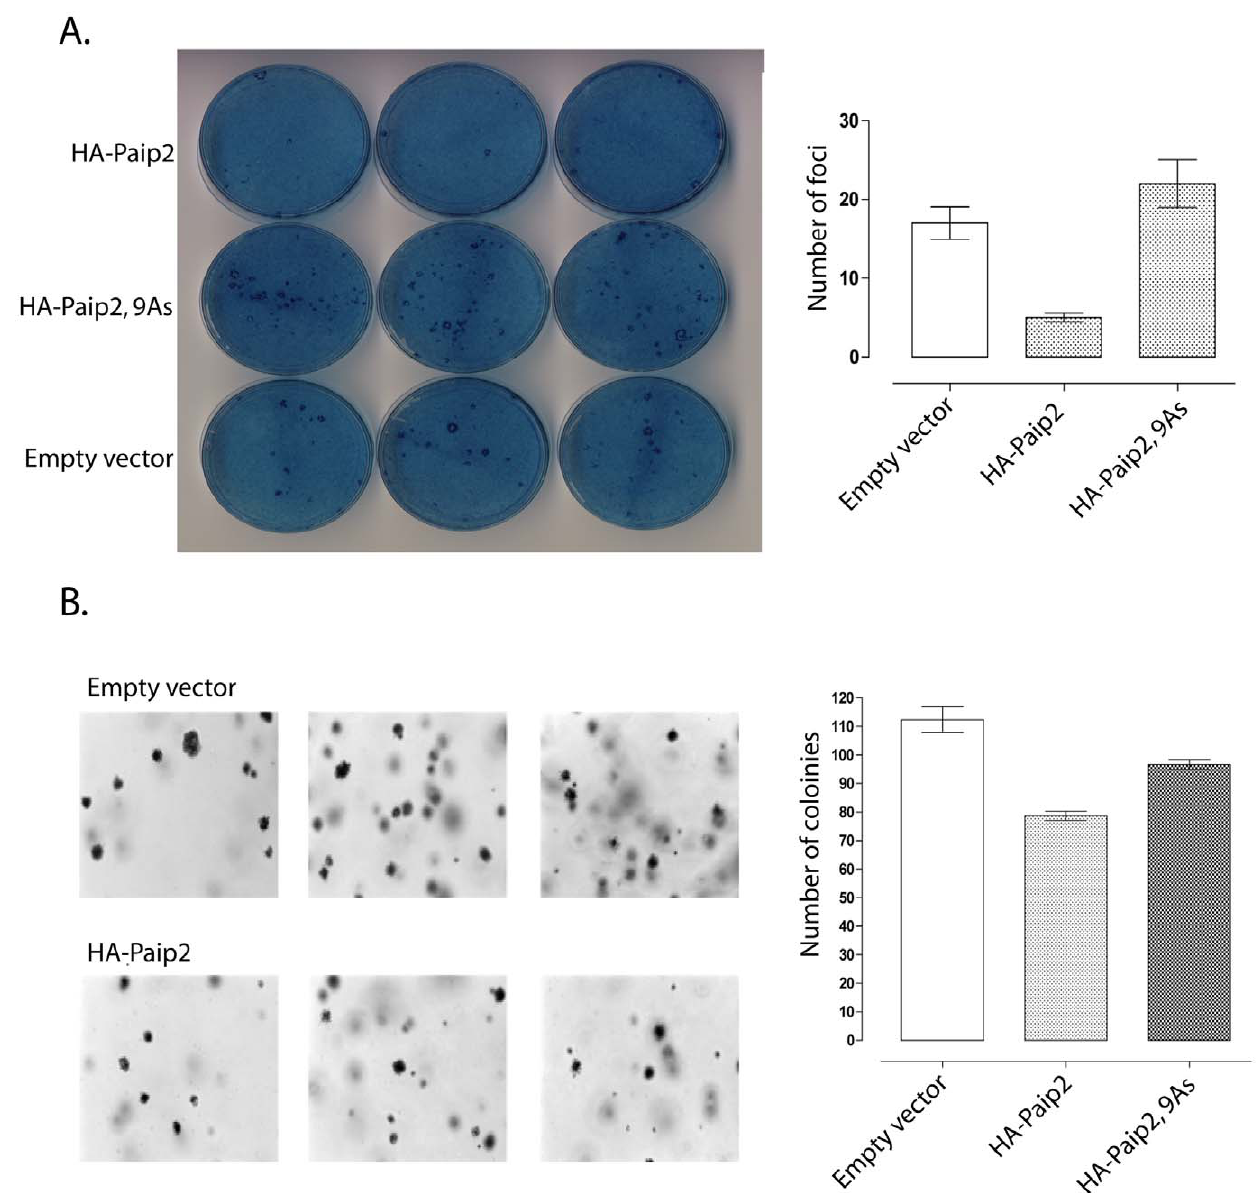
Figure 2. Paip2 impedes cellular transformation by hRas V12 . A. Formation of cell focus by NIH3T3 cells producing hRas V12 and HA-Paip2 or HA-Paip2, 9As on a monolayer of NIH3T3cells. B. Impairment of anchorage independent cell growth of NIH3T3 cells producing hRas V12 by